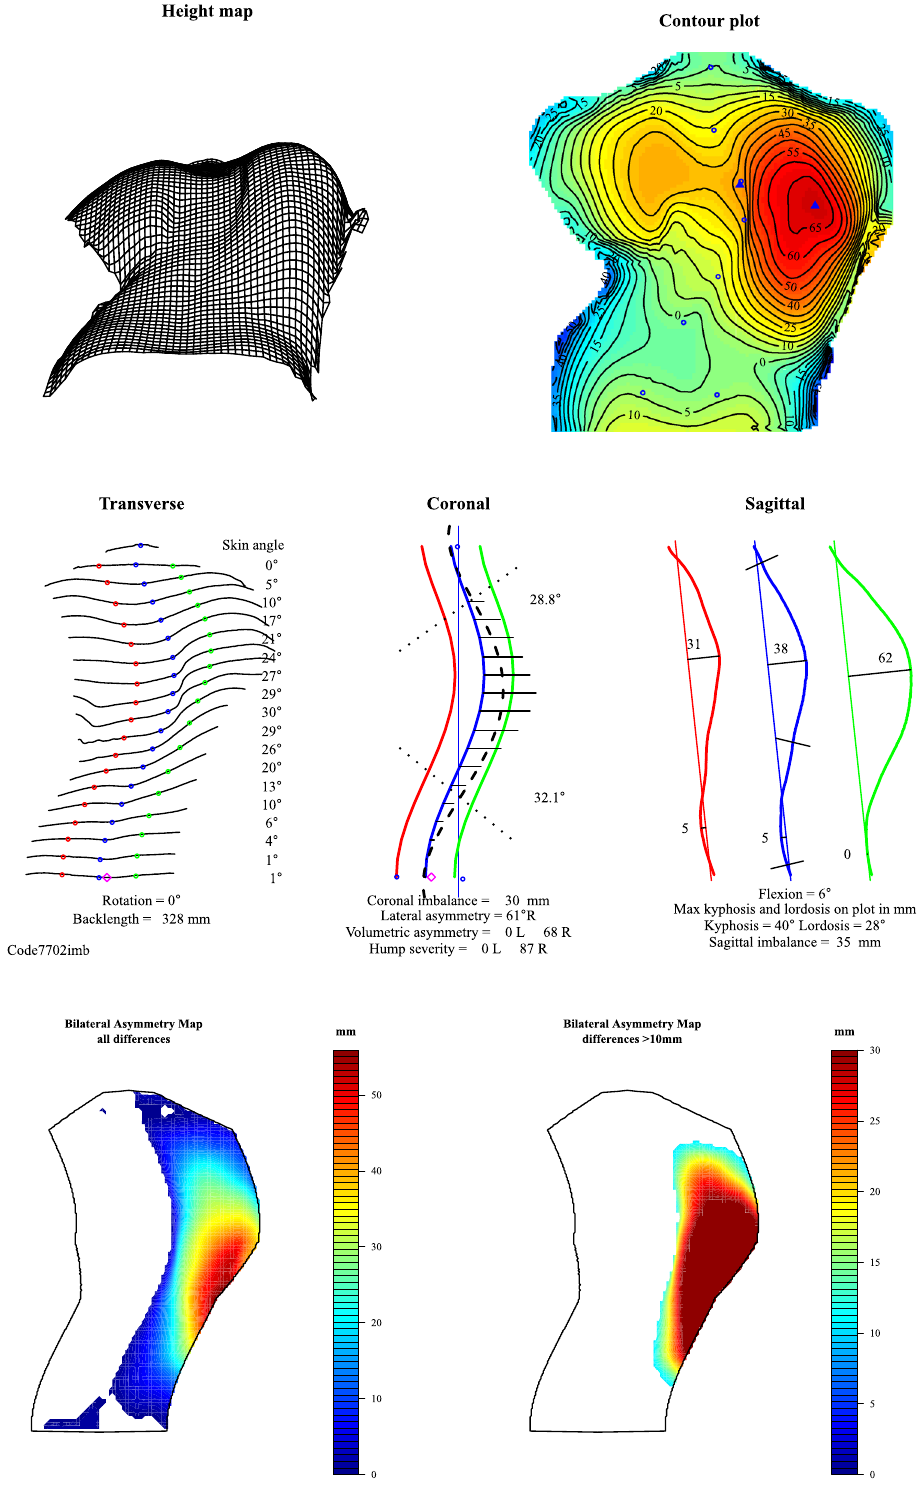
Figure 2. The ISIS2 analysis, describing a number of parameters of spinal and torso